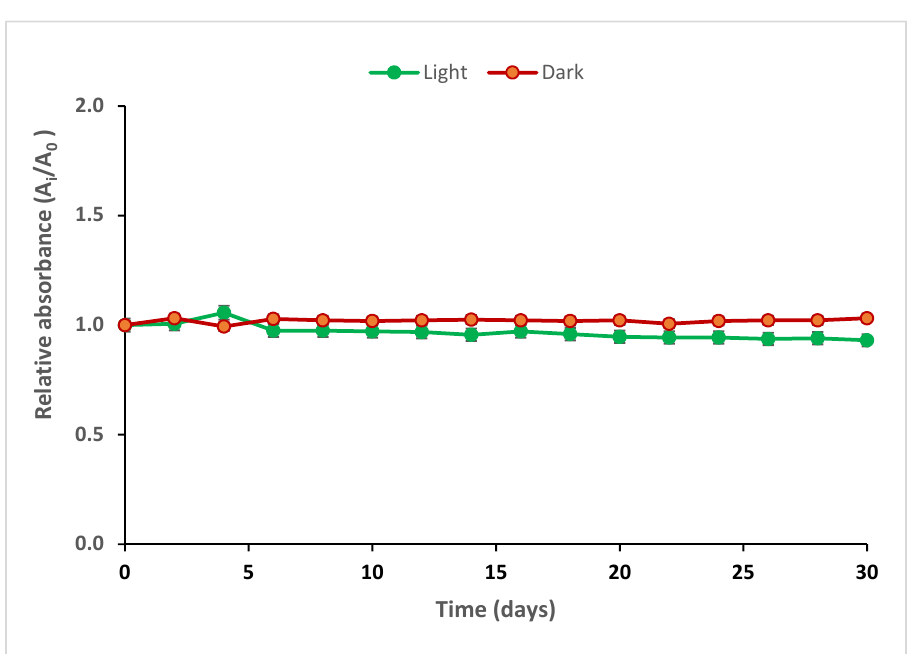
Figure 1. Post-irradiation stability of PVA/Ag + /NBT films after exposure to an X-ray dose of 20 mGy.